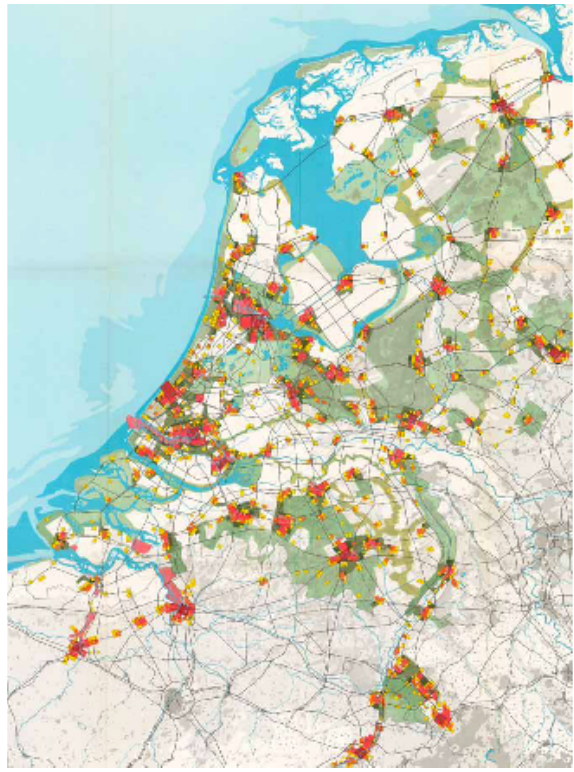
Figure 2. Blokjeskaart in 1966. Notes: Type A in yel- low (5,000 inhabitants), type B in orange (15,000 inhab- itants), type C in red (60,000 inhabitants), and type D in brown (250,000 inhabitants). The first urbanisation type had local bus service, while the rest had a railway station and intercity bus or express train service (Maas,